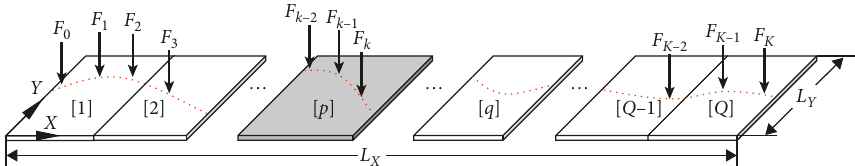
Figure 6: Frequency-domain representation of a moving point force on the multispan plate.